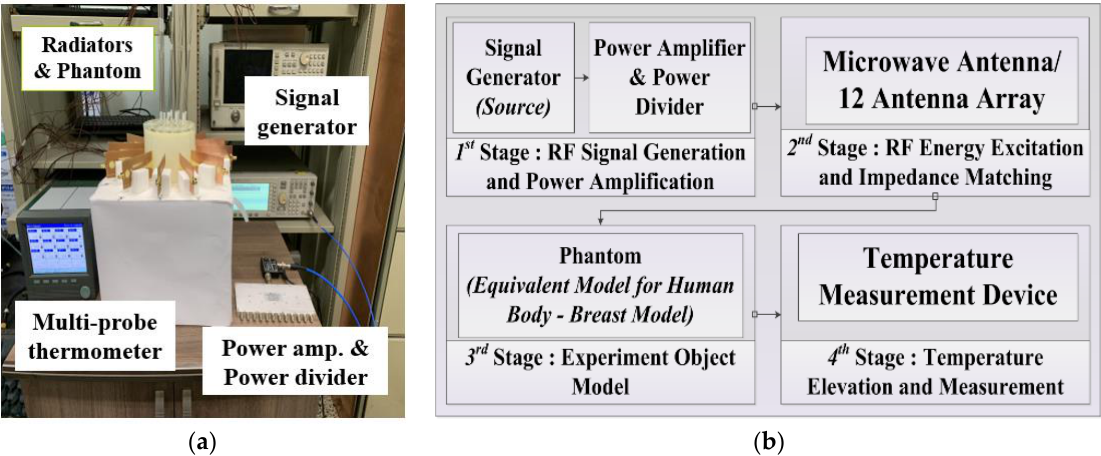
Figure 15. ( a ) Configuration of the temperature measurement setup, and ( b ) block diagram of the temperature measuring